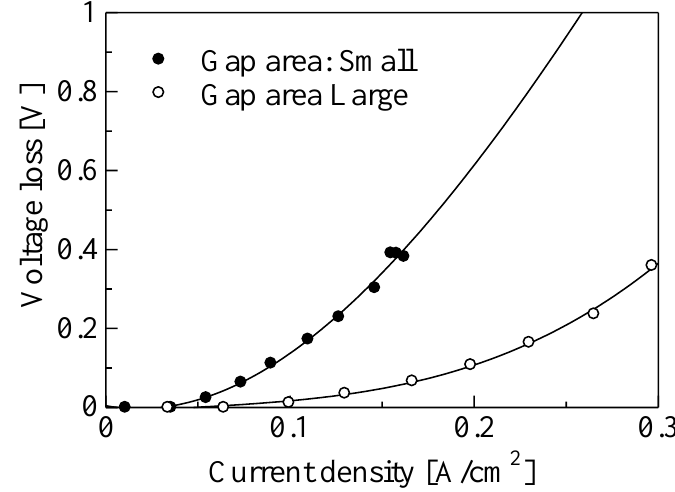
Figure 12. Diffusion polarization for different gap areas.